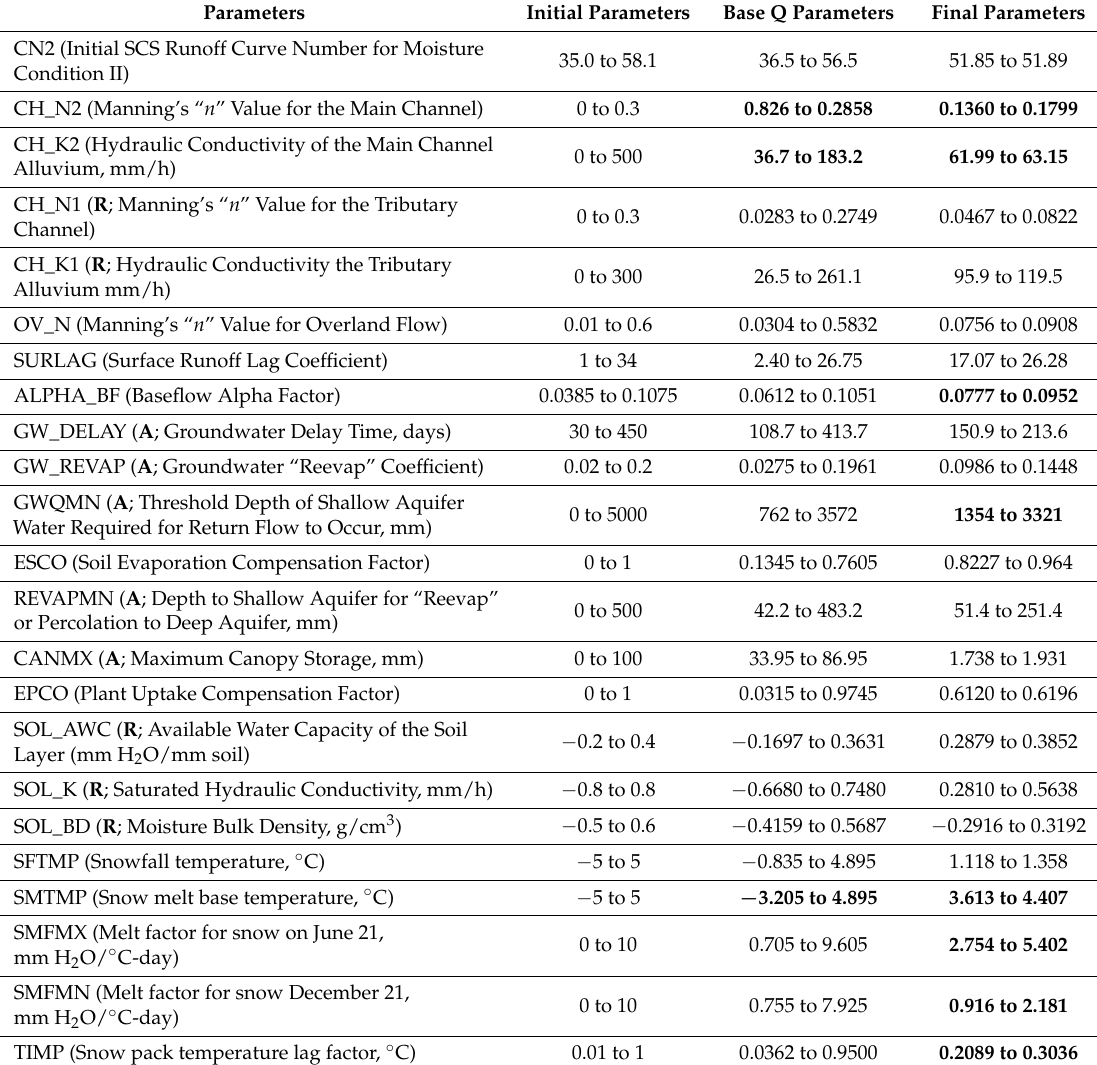
Table 2. Streamflow parameters for the Upper North Fork Basin. R indicates change by Multiplication and A , addition. All other changes are by replacement or absolute adjustments. Numbers in bold indicate a highly sensitive parameter ( p <